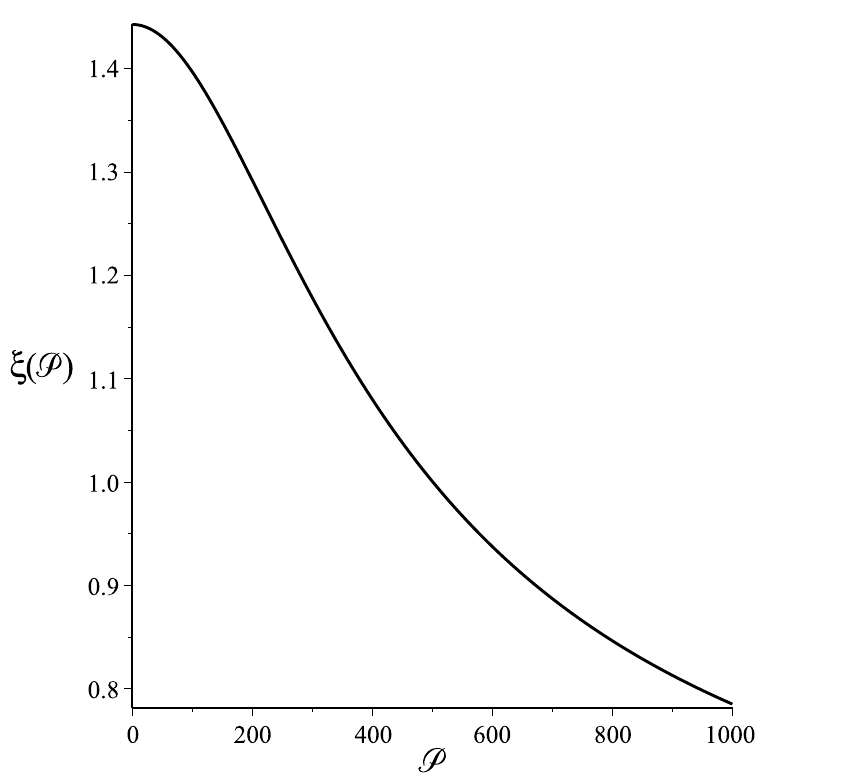
Figure 1 . ξ ( P ) with L = 100 , a = 50 . (Units are Planck